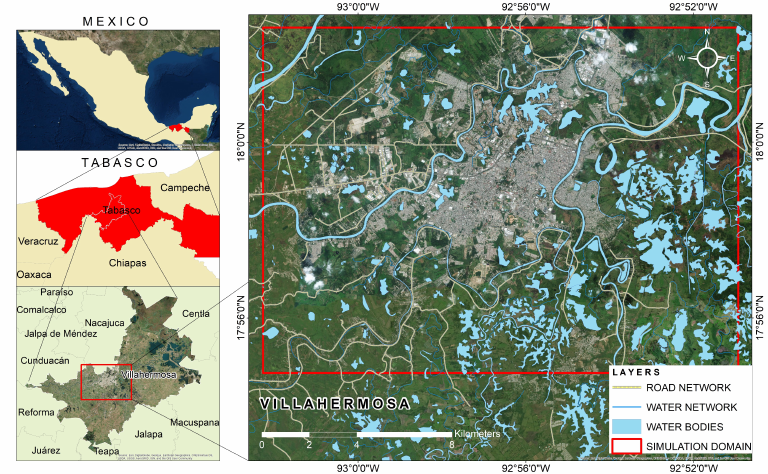
Figure 3. Location map of the area under study. Limits of the city, as well as water networks, are shown. The computation domain is limited by a red